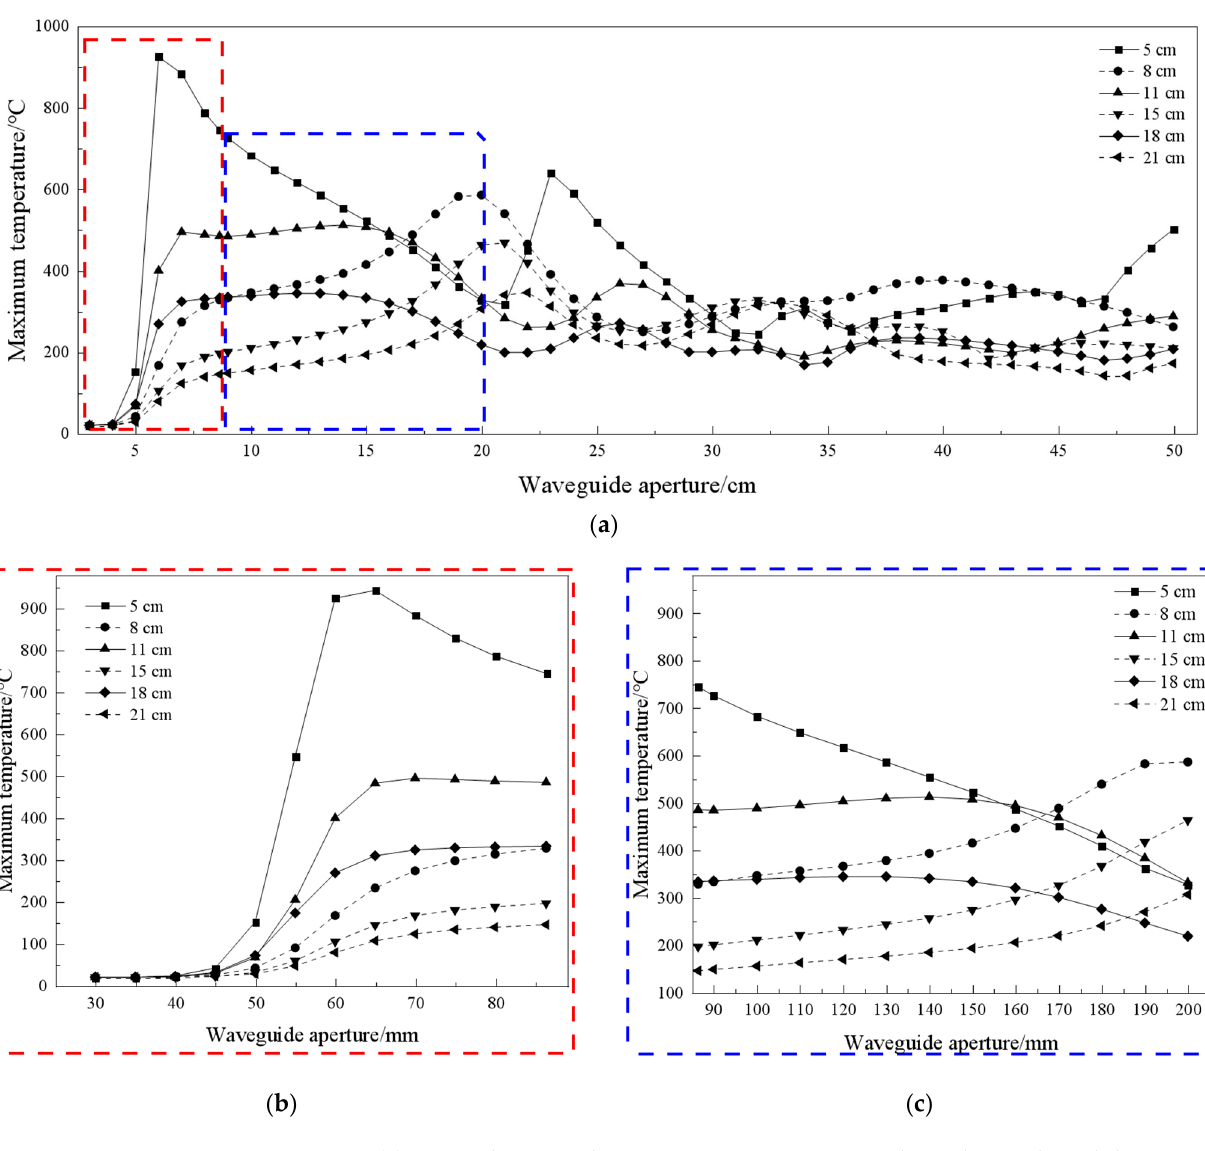
Figure 7. ( a ) Curves between the maximum temperature in the rock sample and the waveguide aperture. ( b ) Convergent waveguide (red dashed box); ( c ) horn waveguide (blue dashed box).